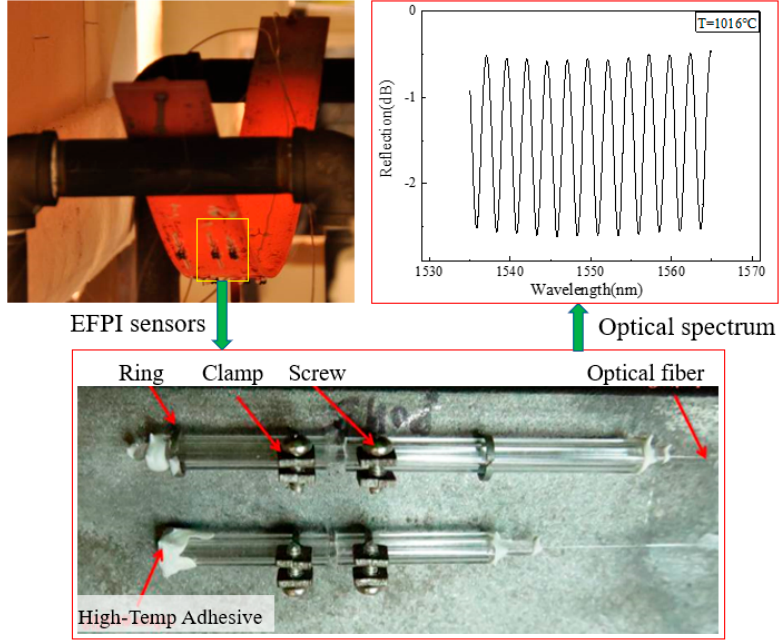
Figure 6. Application of EFPI for large strain measurement in a fire experiment of steel plates.